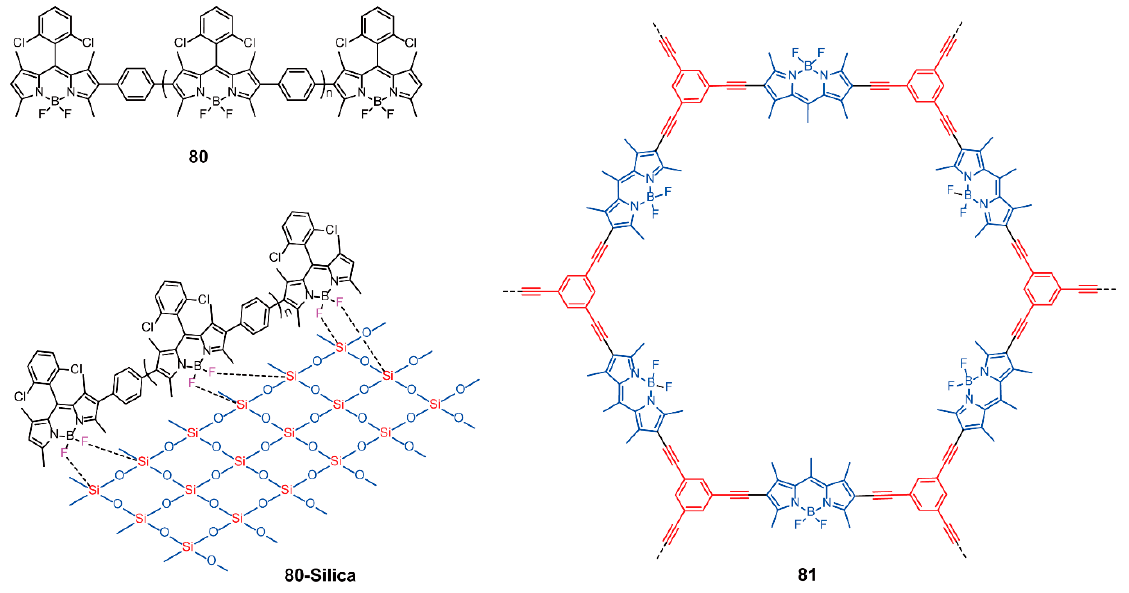
Figure 28. Chemical structures of polymers 80 , 80-silica , and 81 (Reproduced with permission from Reference [104]. Copyright @ 2015 Elsevier B.V. Reproduced with permission from Reference [105]. Copyright @ 2016, American Chemical Society). Table 2. Summary of the applications and synthetic methods of BODIPY-based conjugated polymers. Functional Applications of